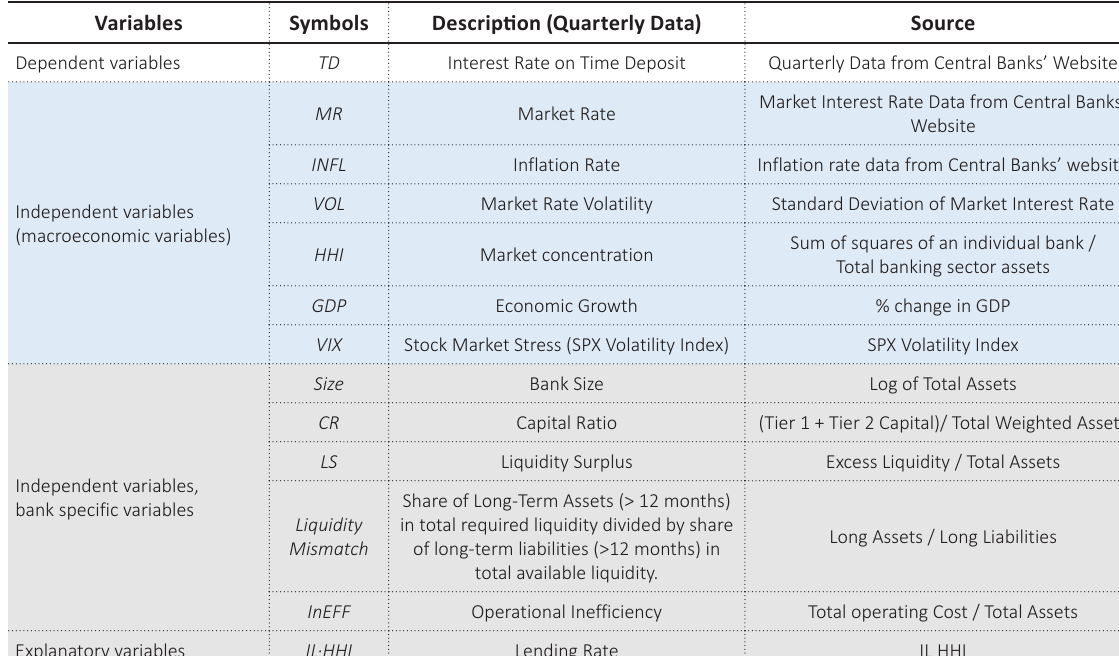
Source: Bikker and Gerritsen